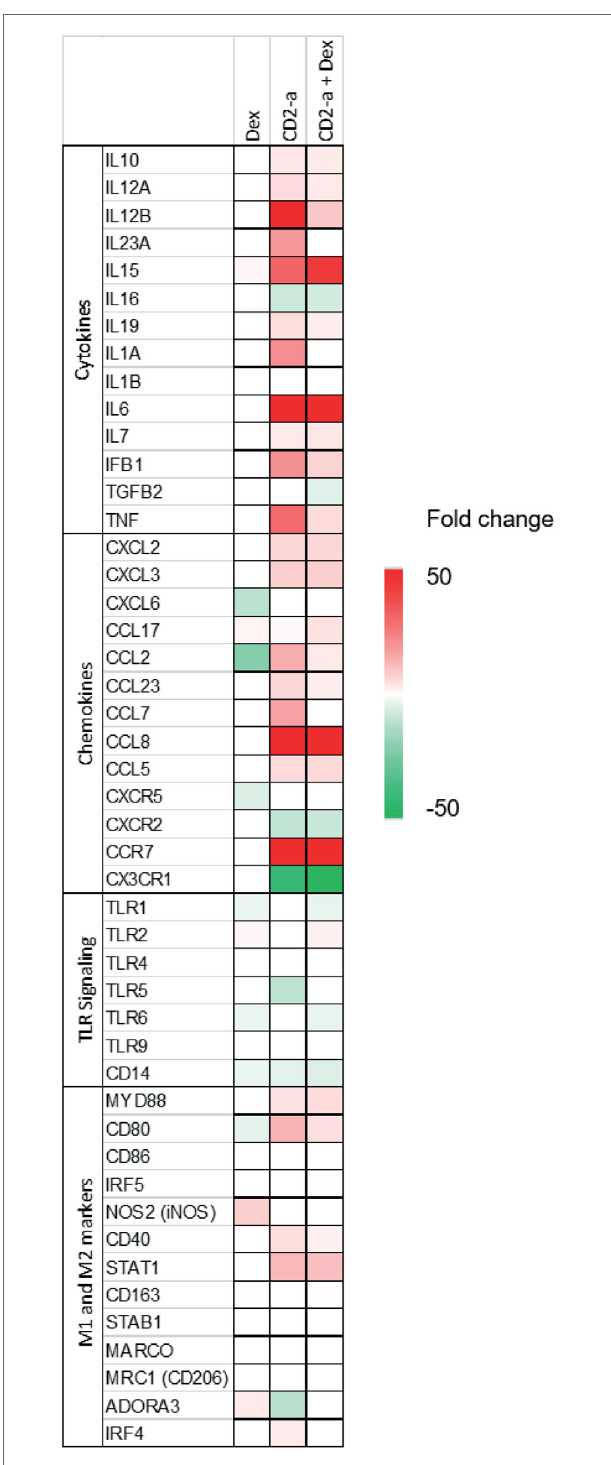
FigUre 2 | Dex and CD2-a modulated gene expression of multiple inflammatory genes. Genes that showed statistically significant differences for any of the three conditions and that affect immune response were selected and grouped into four categories: (1) cytokines, (2) chemokines, (3) TLR signaling, and (4) M1 and M2 markers. The heatmap indicates increased (red/upregulated) or decreased (green/downregulated) expression levels when subjected to each group, compared to